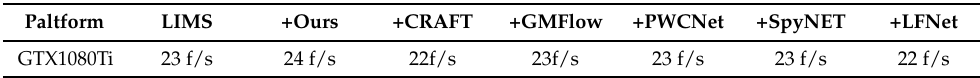
Table 6. The comparison of running speed of LIMS model fine-tuned with different optical flow models, the running speed is measured in frames per second(f/s), “+” indicates fine-tuning of LIMS using different optical flow models, “Ours” represents our optical flow